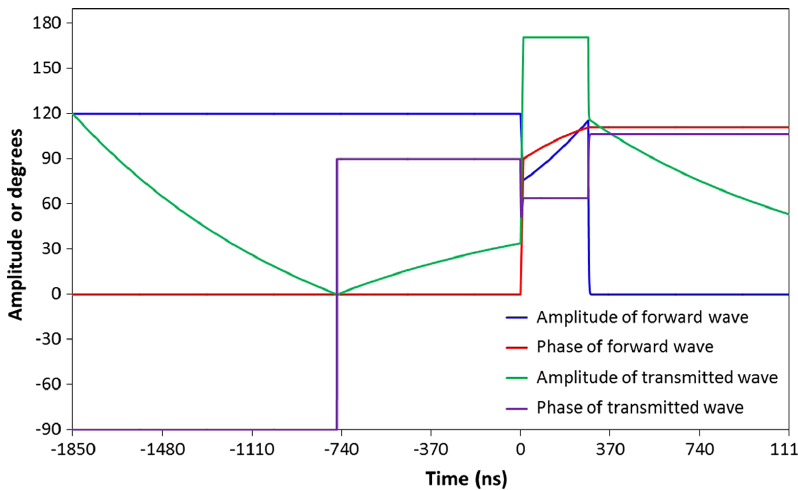
FIG. 5. Simulated pulse after application of the feed forward algorithm for several iterations until convergence is